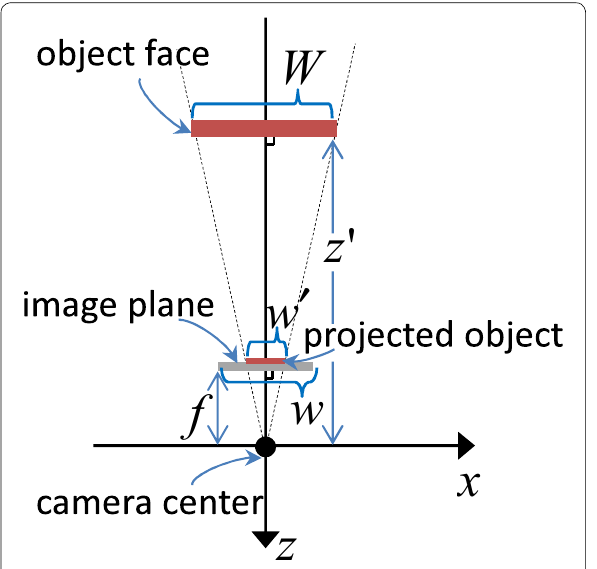
Fig. 6 Diagram of perspective camera model in 2D